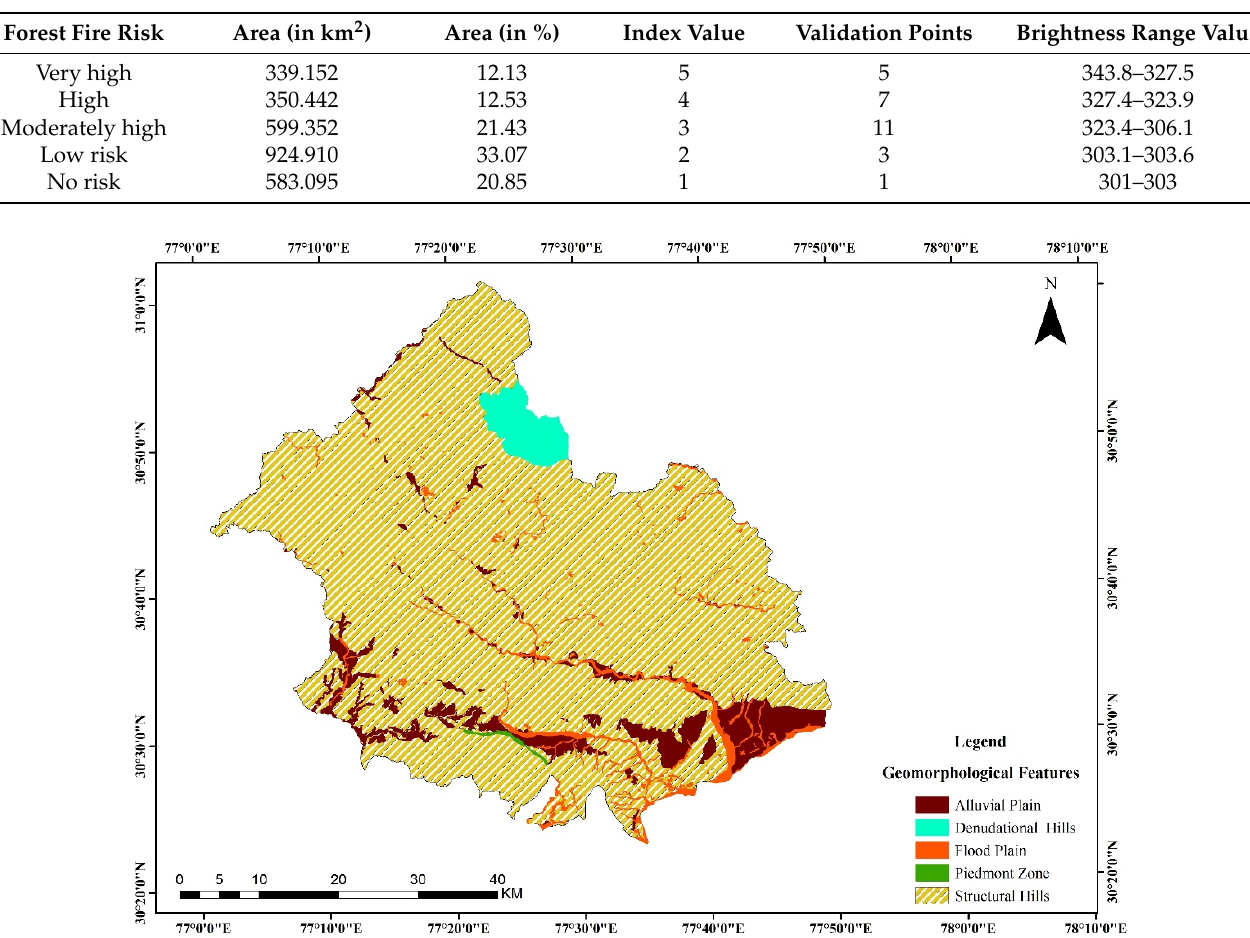
Table 5. Forest fire risk area distribution with validation points.